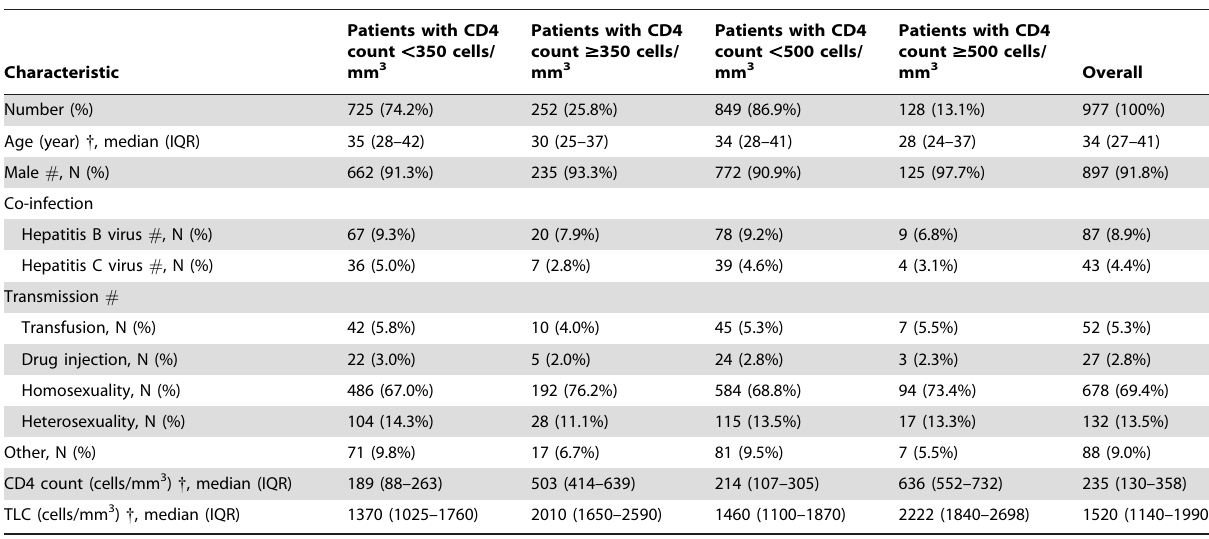
Table 1. Characteristics of the 977 HIV-infected patients included in the study.